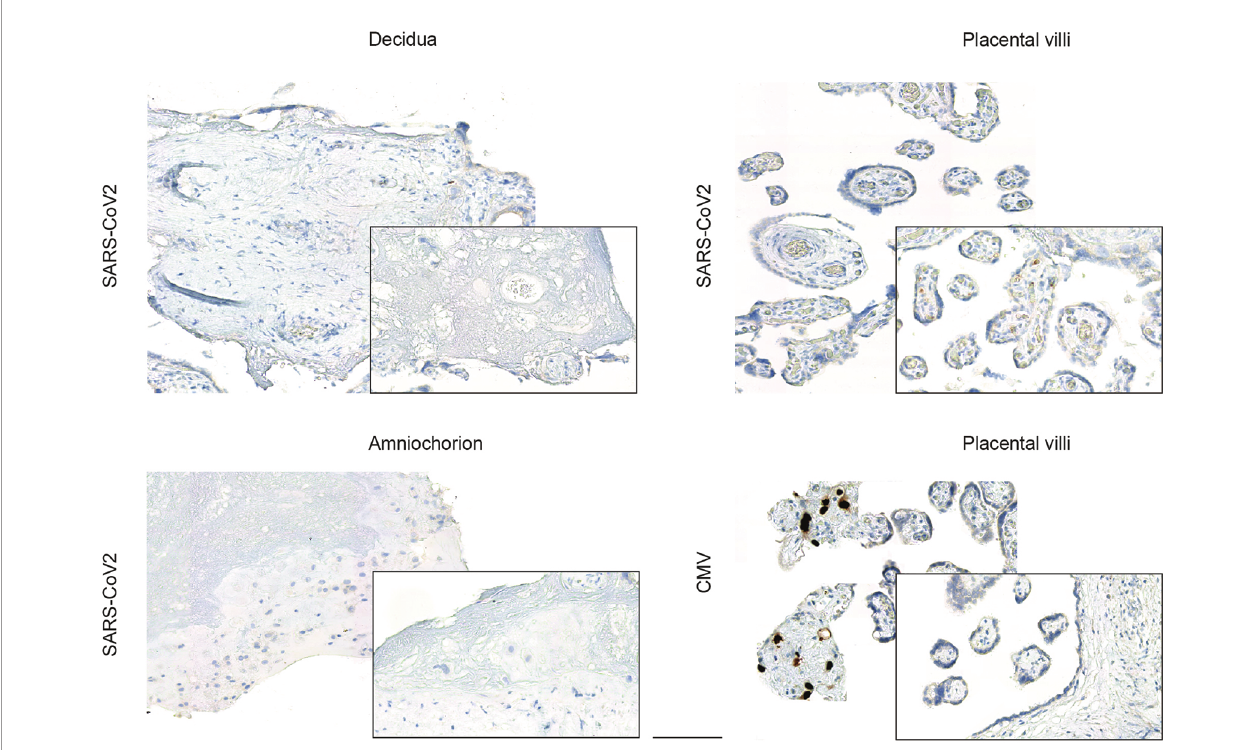
FIGURE 2 | Viral expression in placental explants upon inoculation with human SARS-CoV-2 or CMV isolate. Photomicrographs of placental explants generated from the decidua basalis, the chorionic villi and the amniochorionic membranes were stained for SARS-CoV-2 or CMV expression respectively by IHC, as indicated on left. Inoculation of explants from different anatomical regions of the placenta with a human SARS-CoV-2 isolate did not yield to viral expression, whereas inoculation with CMV con fi rmed CMV-speci fi c immediate-early antigen expression by IHC predominately in placental villi (bottom left). Bar represents 100